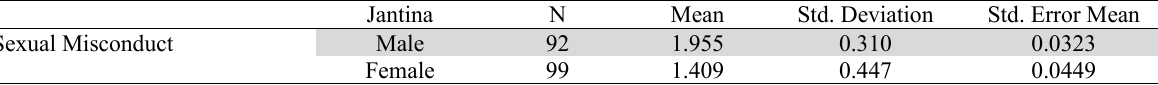
Result of descriptive statistics using independent t-test for Sexual Misconduct